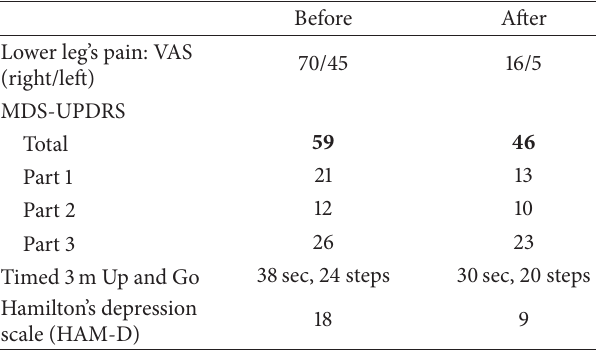
Table 1: The assessment before and after two-week treatment of